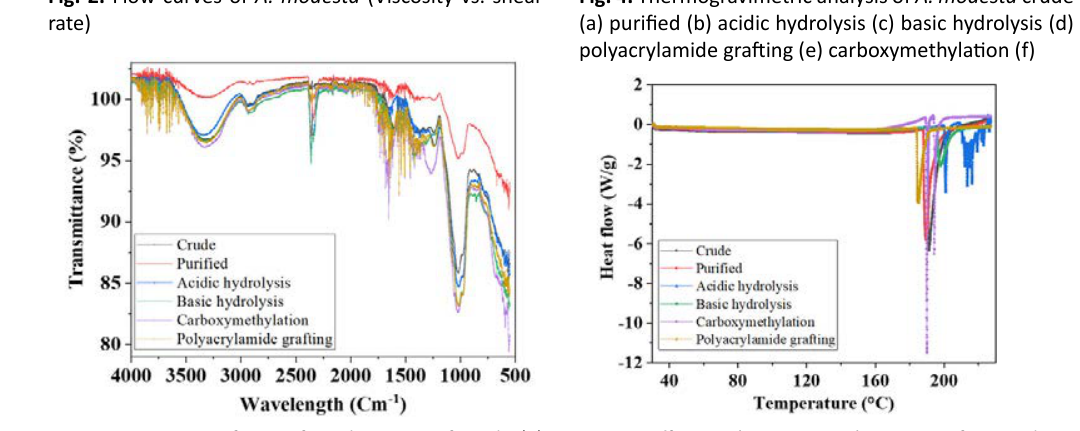
Fig. 5. Differential scanning calorimetry of A. modesta crude (a) purified (b) acidic hydrolysis (c) basic